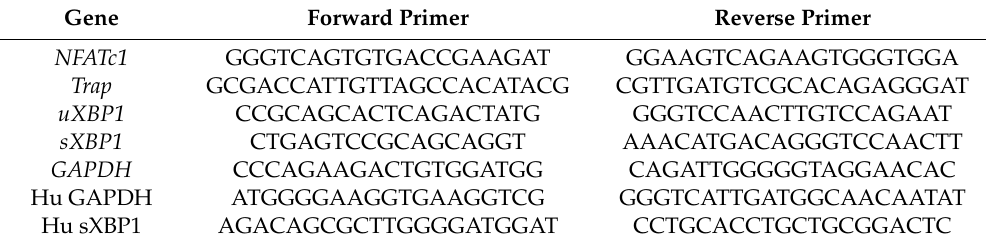
Table 1. Gene primers used to study gene expression